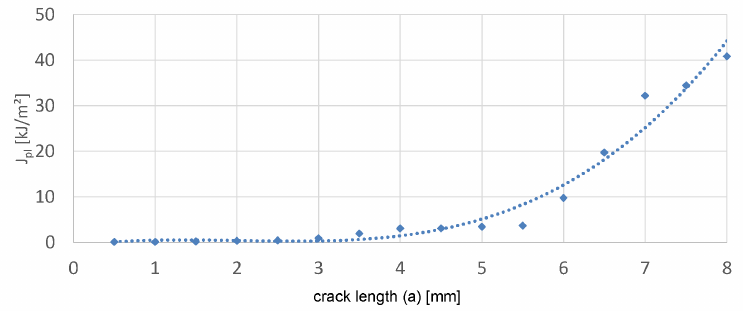
Figure 11. J pl for the large sample calculated based on the sample parameters and the crack opening shown in Figure 10.